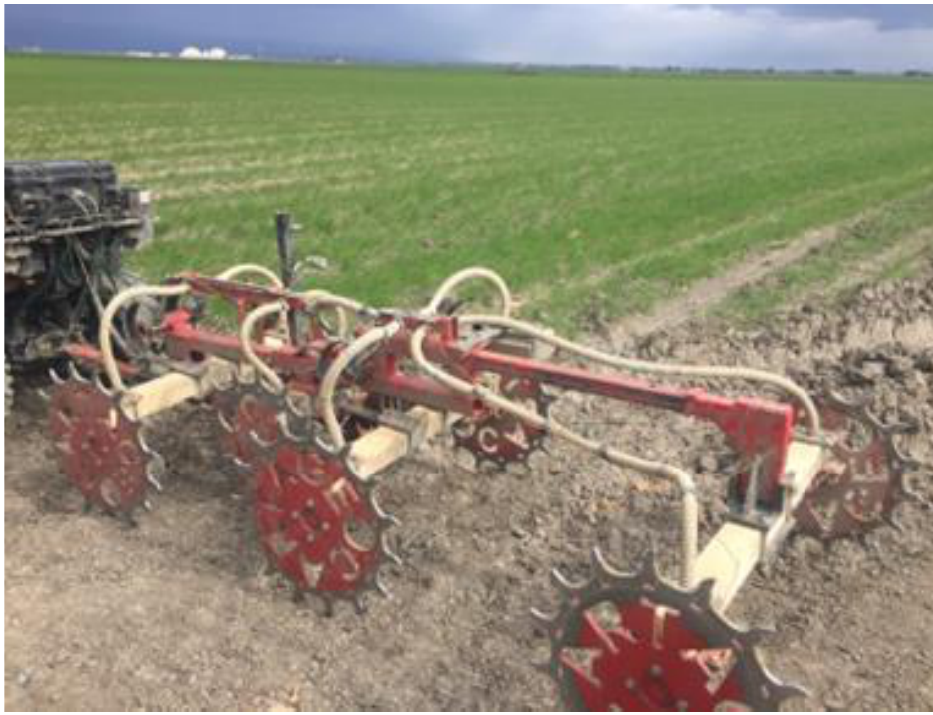
Figure 2. Mobile system to measure the electrical potential difference.